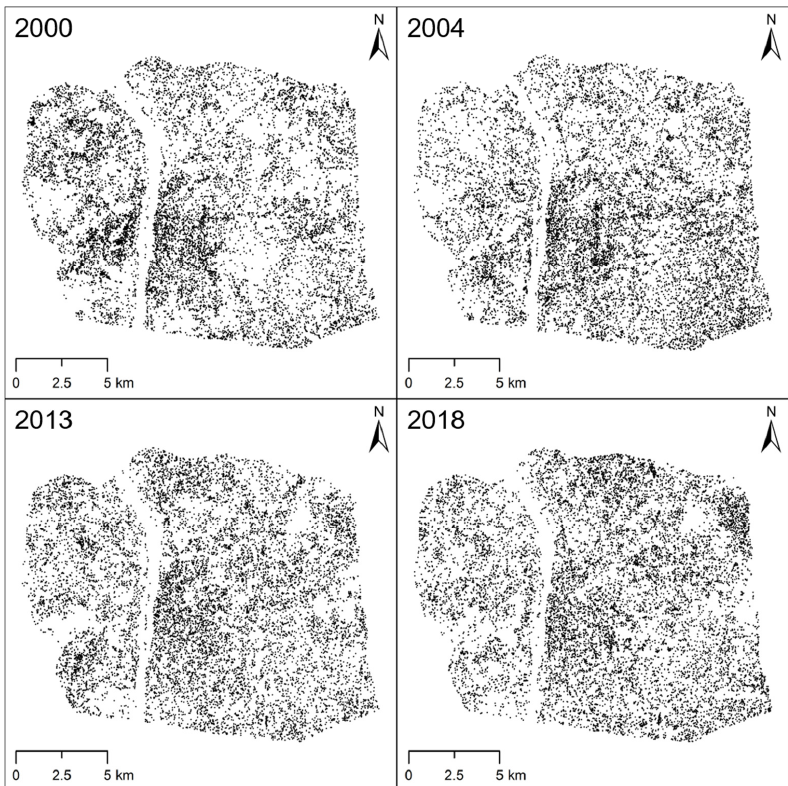
Atmosphere 2021 , 12 , x FOR PEER REVIEW Figure 6. Spatial distribution of the PIFs for 2000, 2004, 2013, and 2018. Figure 6. Spatial distribution of the PIFs for 2000, 2004, 2013, and 2018.